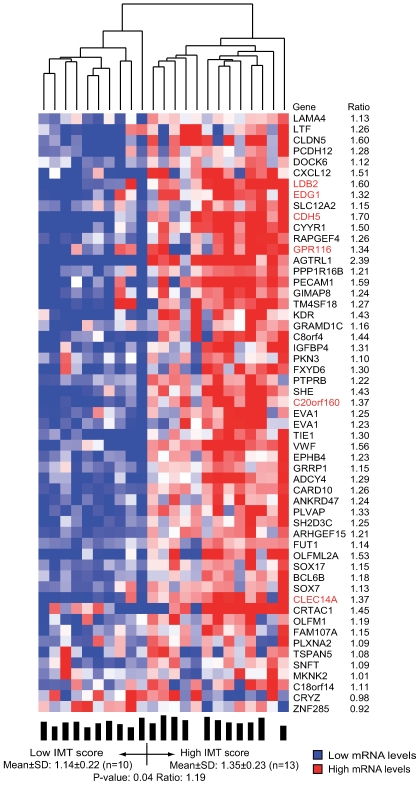
Heat map of a carotid stenosis cluster related to IMT.The cluster was defined by related mRNA levels (indicated by average probe signals on the arrays) and identified as one of eight carotid stenosis clusters by the second step of coupled two-way clustering of mRNA profiles from Carotid Stenosis patients (Text S1). Columns represent individual patients, and rows individual RefSeqs with corresponding gene symbols and mRNA ratios of the two patient groups. Below heat map: bars indicating individual IMT together with means ± SD and average ratios in each group and P-values for comparing groups. Red highlighting indicates genes also identified in the clusters in Figure 2 and Figure 3. EVA1 is represented by two RefSeqs.